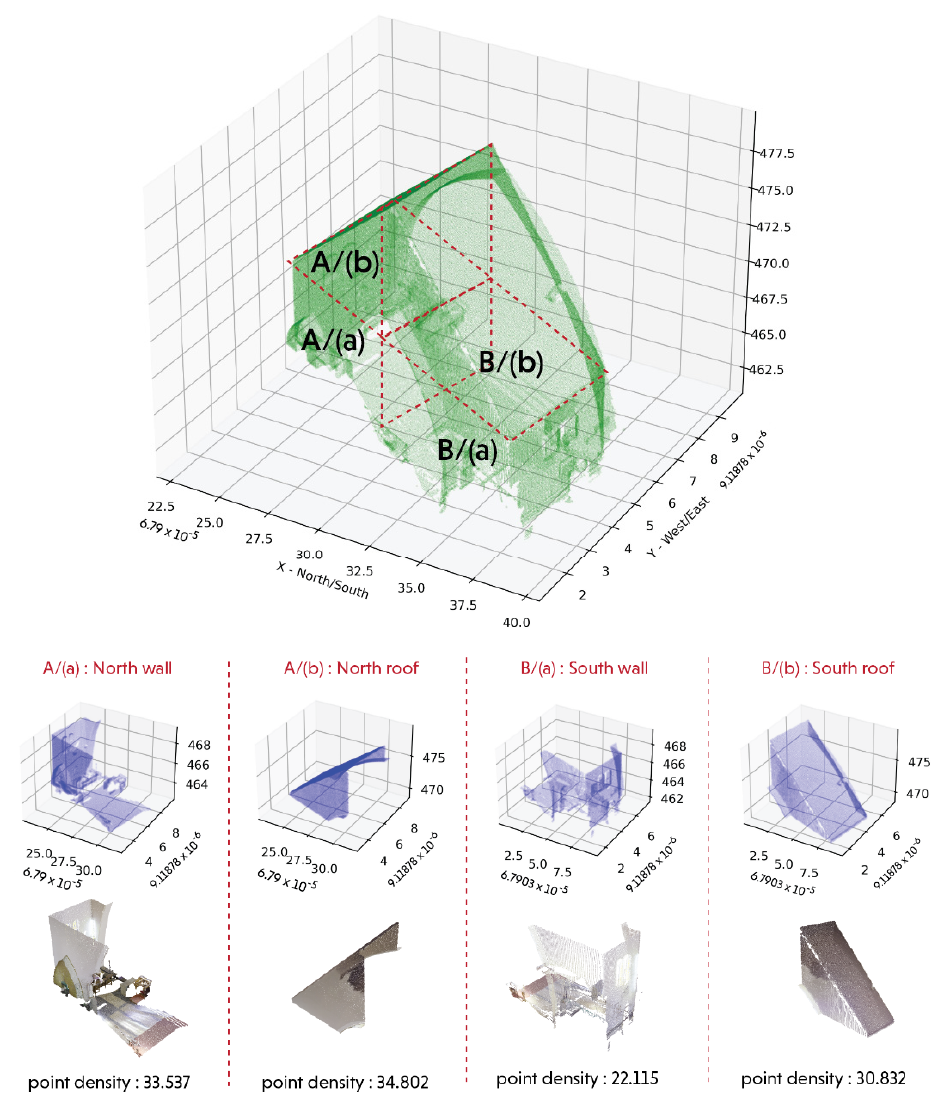
Figure 3. Segmentation of the selected dataset.